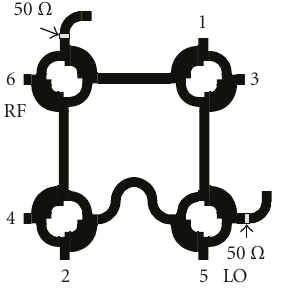
Figure 1: The multiport circuit block diagram.